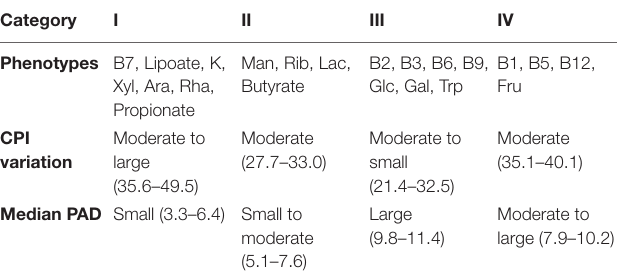
TABLE 3 | Phenotype categories and their observed characteristics.